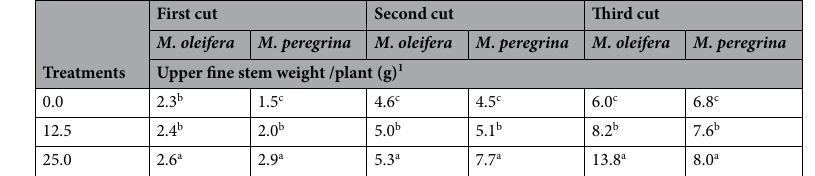
Table 6. The effect of selenium fertilization (mg Se/L) on fresh shoots weight of M. oleifera and M. peregrina at different cutting periods. 1 Means within each column with the same superscripts were not significantly different using Duncan Multiple Range Test at the 0.05 level of